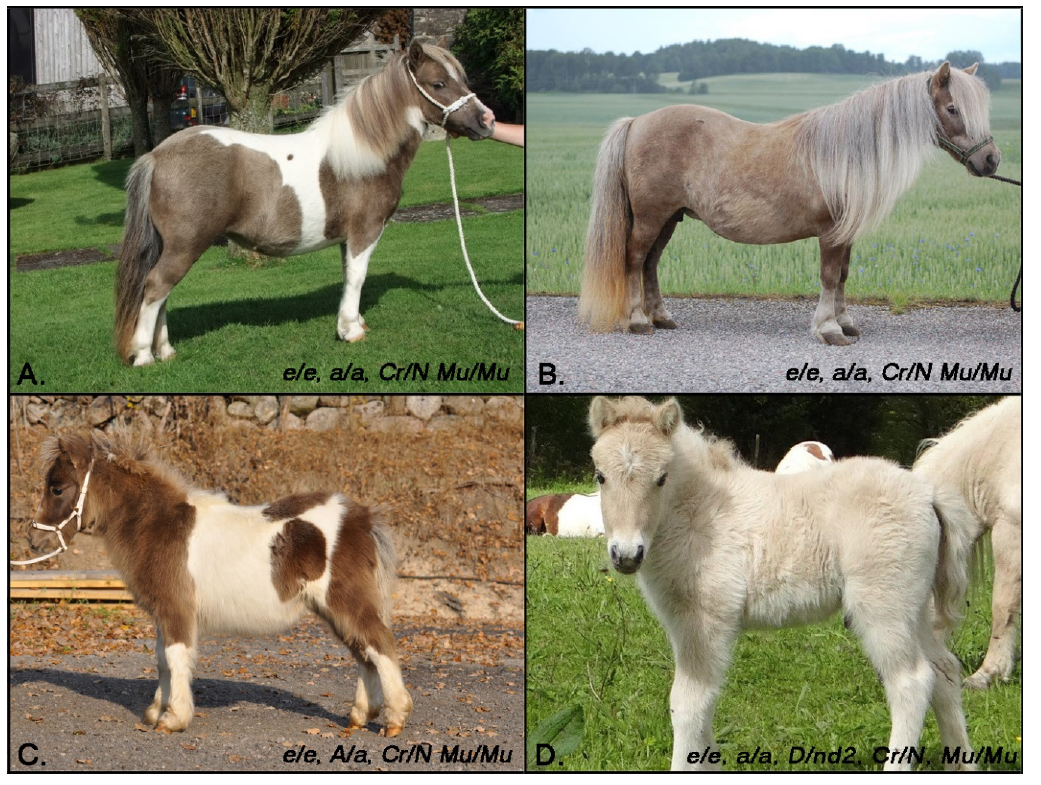
Figure 4. Palomino Mushroom Shetland Ponies. ( A ), ( B ), ( C ) Three palomino mushroom ponies (chestnut background and heterozygous at the cream locus), displaying a phenotype consistent with other mushroom individuals without the cream dilution ranging in shade of mushroom phenotype. ( D ) Dunalino (palomino with the dun dilution) homozygous for the mushroom dilution, displaying an extremely dilute phenotype likely caused by a combination of dun and cream. On all four ponies the head appears to be a darker shade, similar to what is seen on the bay mushroom ponies. Photo credits ( A ) David Hodge. ( D ) Marc and Cecile Letouzé. Table 5. Bay, black and palomino ponies homozygous for MFSD12 c.600dupC. Twelve Shetland Ponies were identified as being homozygous for the mushroom variant on a non-chestnut